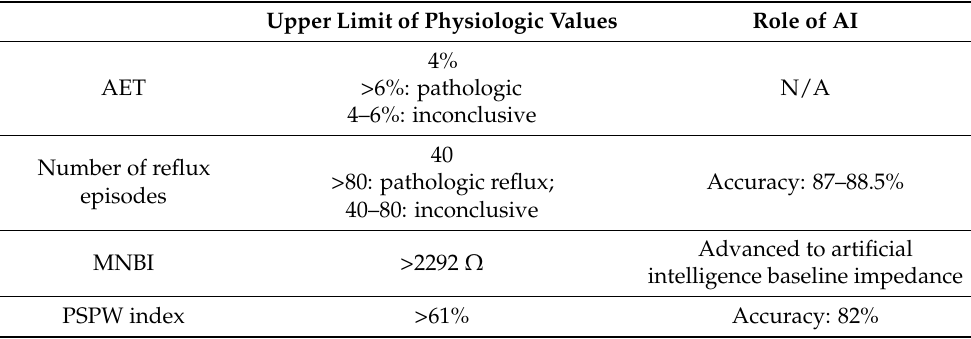
N/A Accuracy: 87–88.5% Advanced to artificial intelligence baseline